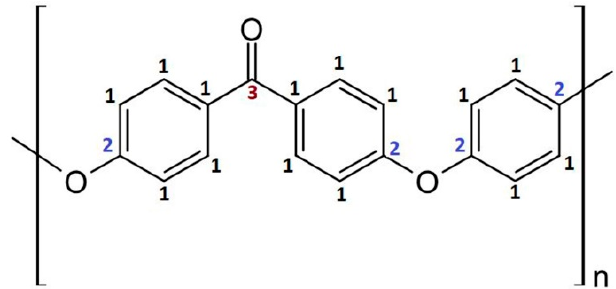
Figure 5. Chemical structure of PEEK’s mer unit.